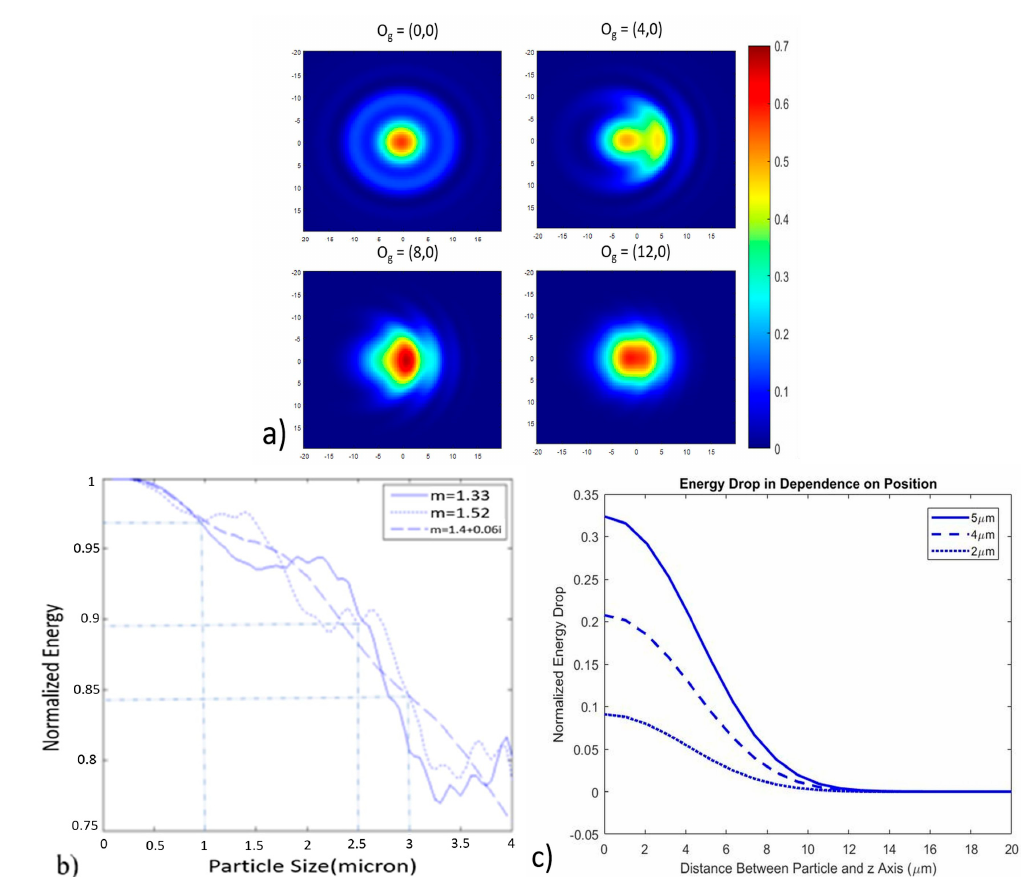
Figure 3. ( a ) Some simulated total forward intensity distribution on the xy plane (the wave propagation is along the z axis) after scattering by on-axis and off-axis particles (here, on-axis means the particle is on the z axis, off-axis means the particle is not on the z axis). OG specifies the position of the particle, the unit of the coordinates is µm, the particle being simulated has 2 µm radius and